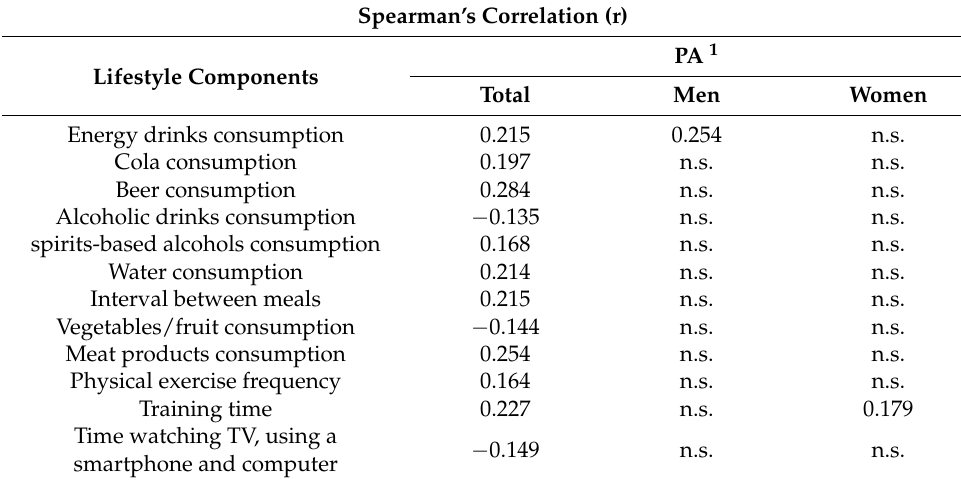
Table 5. Significant correlations ( p < 0.05) between PA and components of lifestyle.